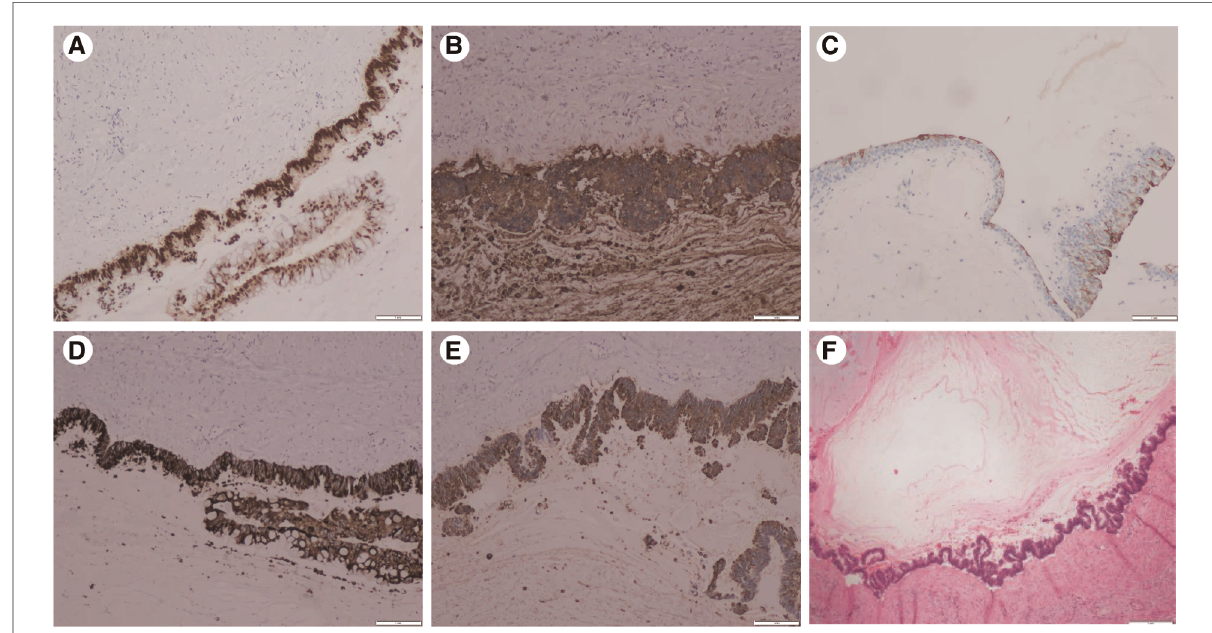
FIGURE 2 Immunohistochemistry results: (A) CDX2(+): diffuse and strong nuclear immunoreactivity for CDX2. (B) CEA(+): diffuse strong staining for the CEA. (C) CK20(+): atypical mucinous epithelium with patchy cytokeratin 20 staining. (D) MUC2(+) and (E) MUC5AC(+): atypical mucinous epithelium with diffuse strong staining for the MUC2 and MUC5AC gene products (×20) (F) pathology: a wide range of mucus lake was observed under the microscope, and the areas of the cyst wall are lined by atypical mucinous epithelium (H&E staining)